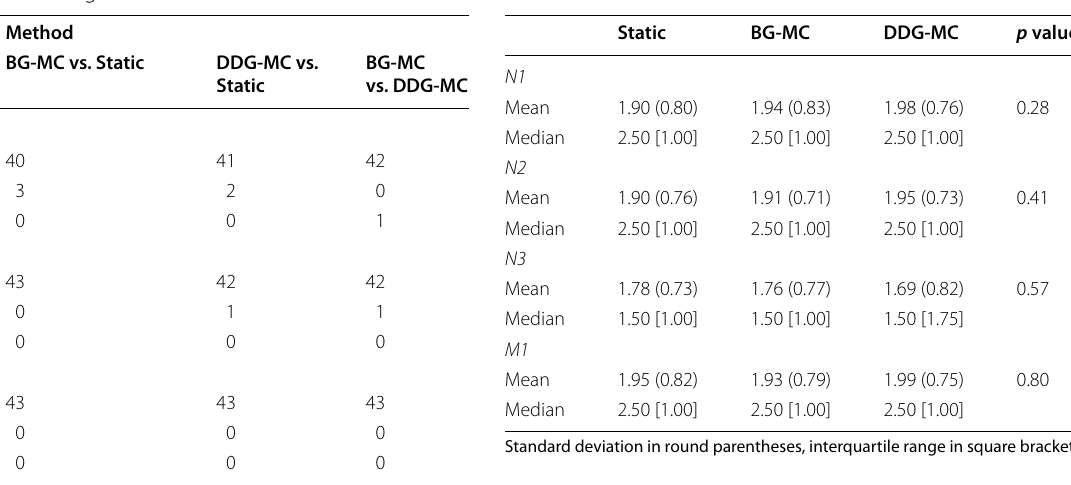
Table 5 Mean and median certainty score c for different reconstruction